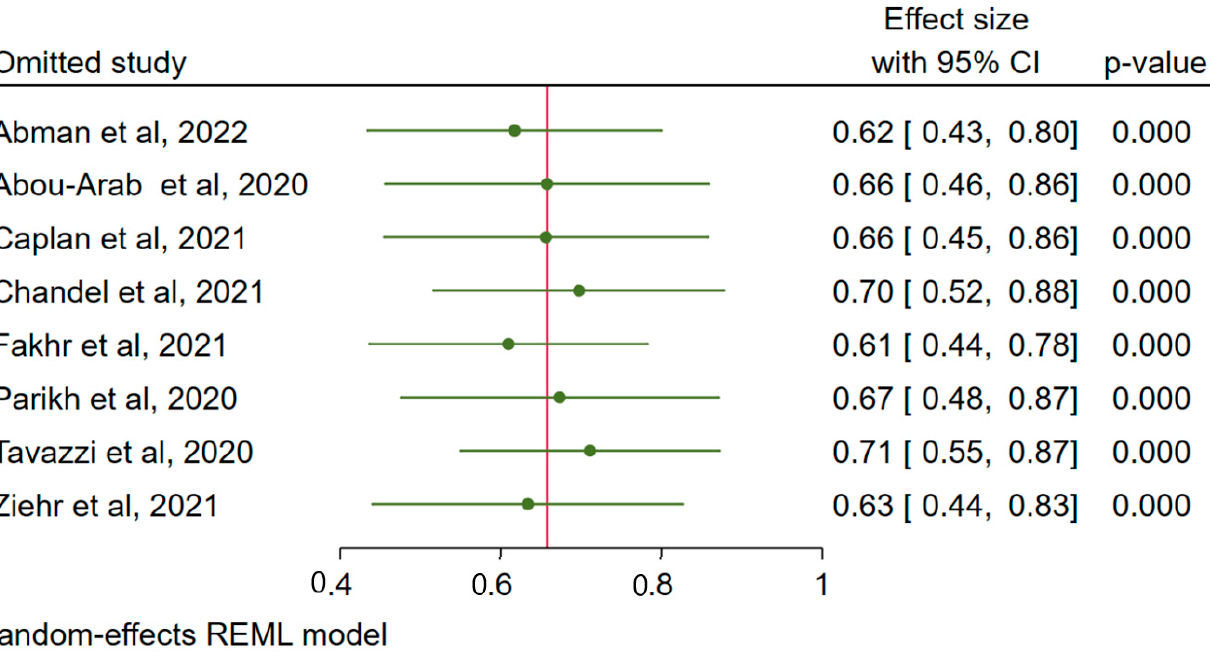
Figure 4. Sensitivity test (leave-one-out analysis) to detect influential studies among the reports pooled for response rate. 95% CI = 95% confidence interval.